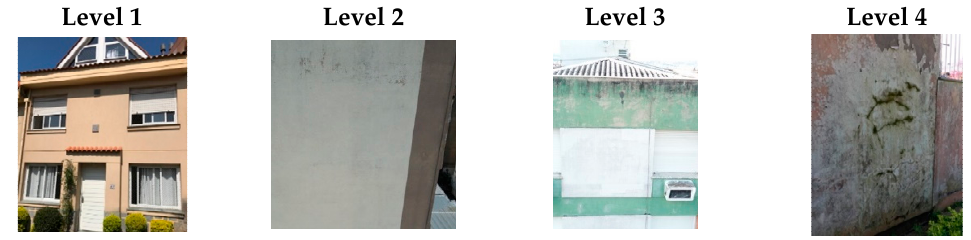
Figure 1. Illustrative examples of the degradation conditions for the painted renderings analyzed.